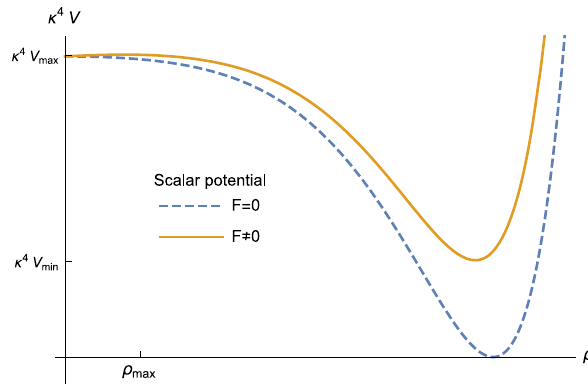
Fig. 1 This plot shows the scalar potentials in F = 0 and F (cid:9)= 0 cases. When F = 0, we have a local maximum at ρ max = 0 and a global minimum with zero cosmological constant. For F (cid:9)= 0, the local maximum is shifted by a small positive value to ρ max (cid:9)= 0. The global minimum now has a positive cosmological